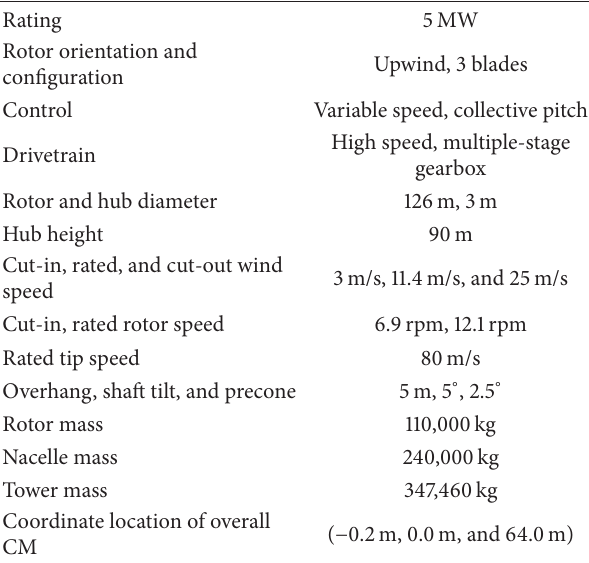
Table2:GrosspropertieschosenfortheNREL5 MWBaselinewind turbine [10].